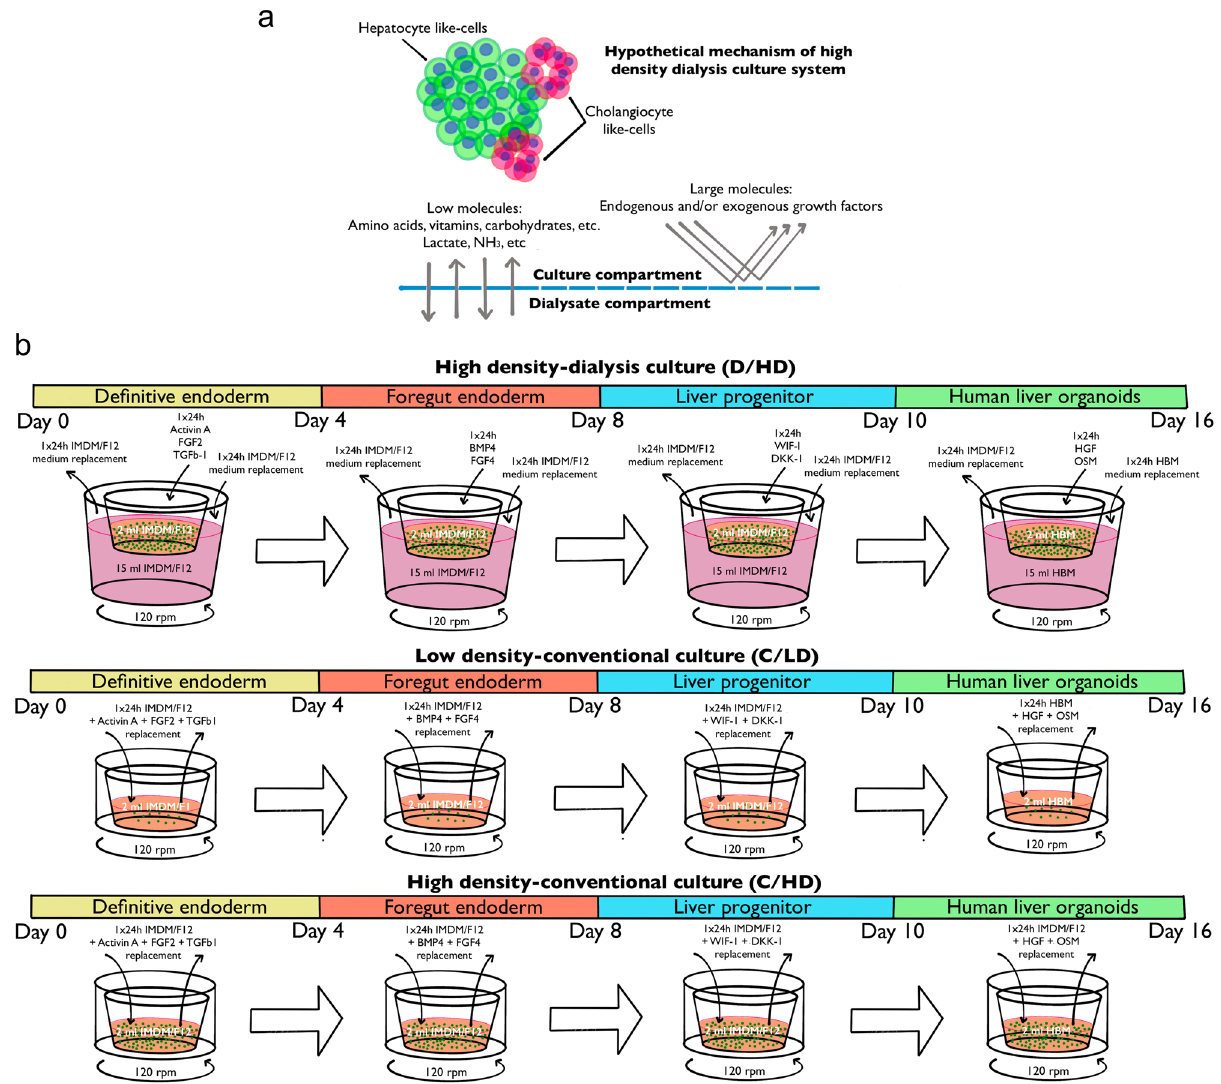
Figure 1. The experimental methodology used in this study. ( a ) The hypothetical mechanism of a high-density dialysis culture system utilizes the semipermeable dialysis membrane to accumulate the large molecule while maintaining culture condition by small molecule exchange. ( b ) The stepwise protocol of hepatic differentiation in the different culture settings and their medium replacement